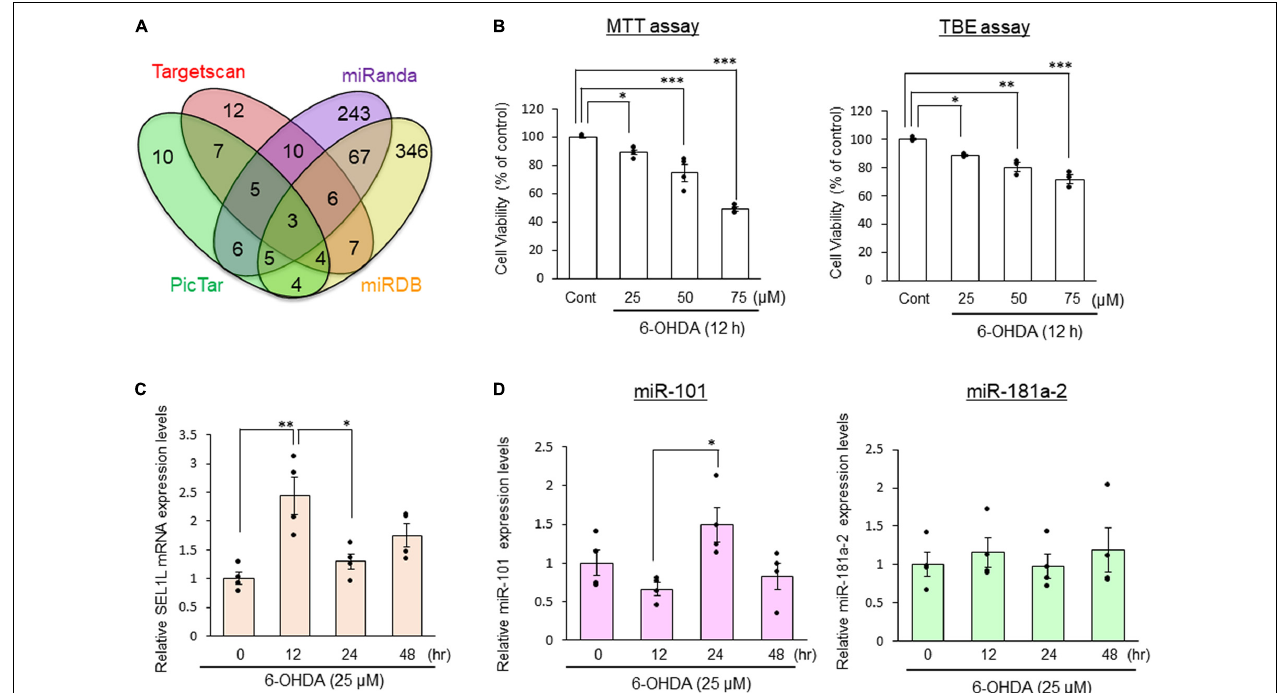
FIGURE 1 | MiR-101 expression is inversely correlated with the mRNA expression of suppressor enhancer Lin12 1-like (SEL1L). (A) Potential targets of SEL1L predicted by the interrogation of four databases (Targetscan, PicTar, miRanda, and miRDB). (B) SH-SY5Y cells were stimulated with 25, 50, or 70 µ